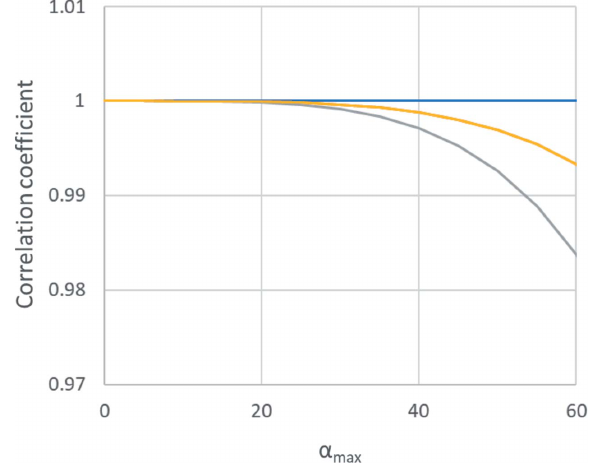
Figure 9 Correlation coefficients between the elliptical distortion and refinement of the orientation matrix, plotted for elliptical distortion phases 0 (cid:2) (blue), 20 (cid:2) and 70 (cid:2) (yellow), and 45 (cid:2)